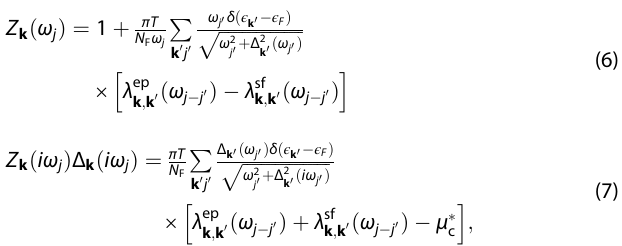
for the out-of-plane fi elds can be compared. c